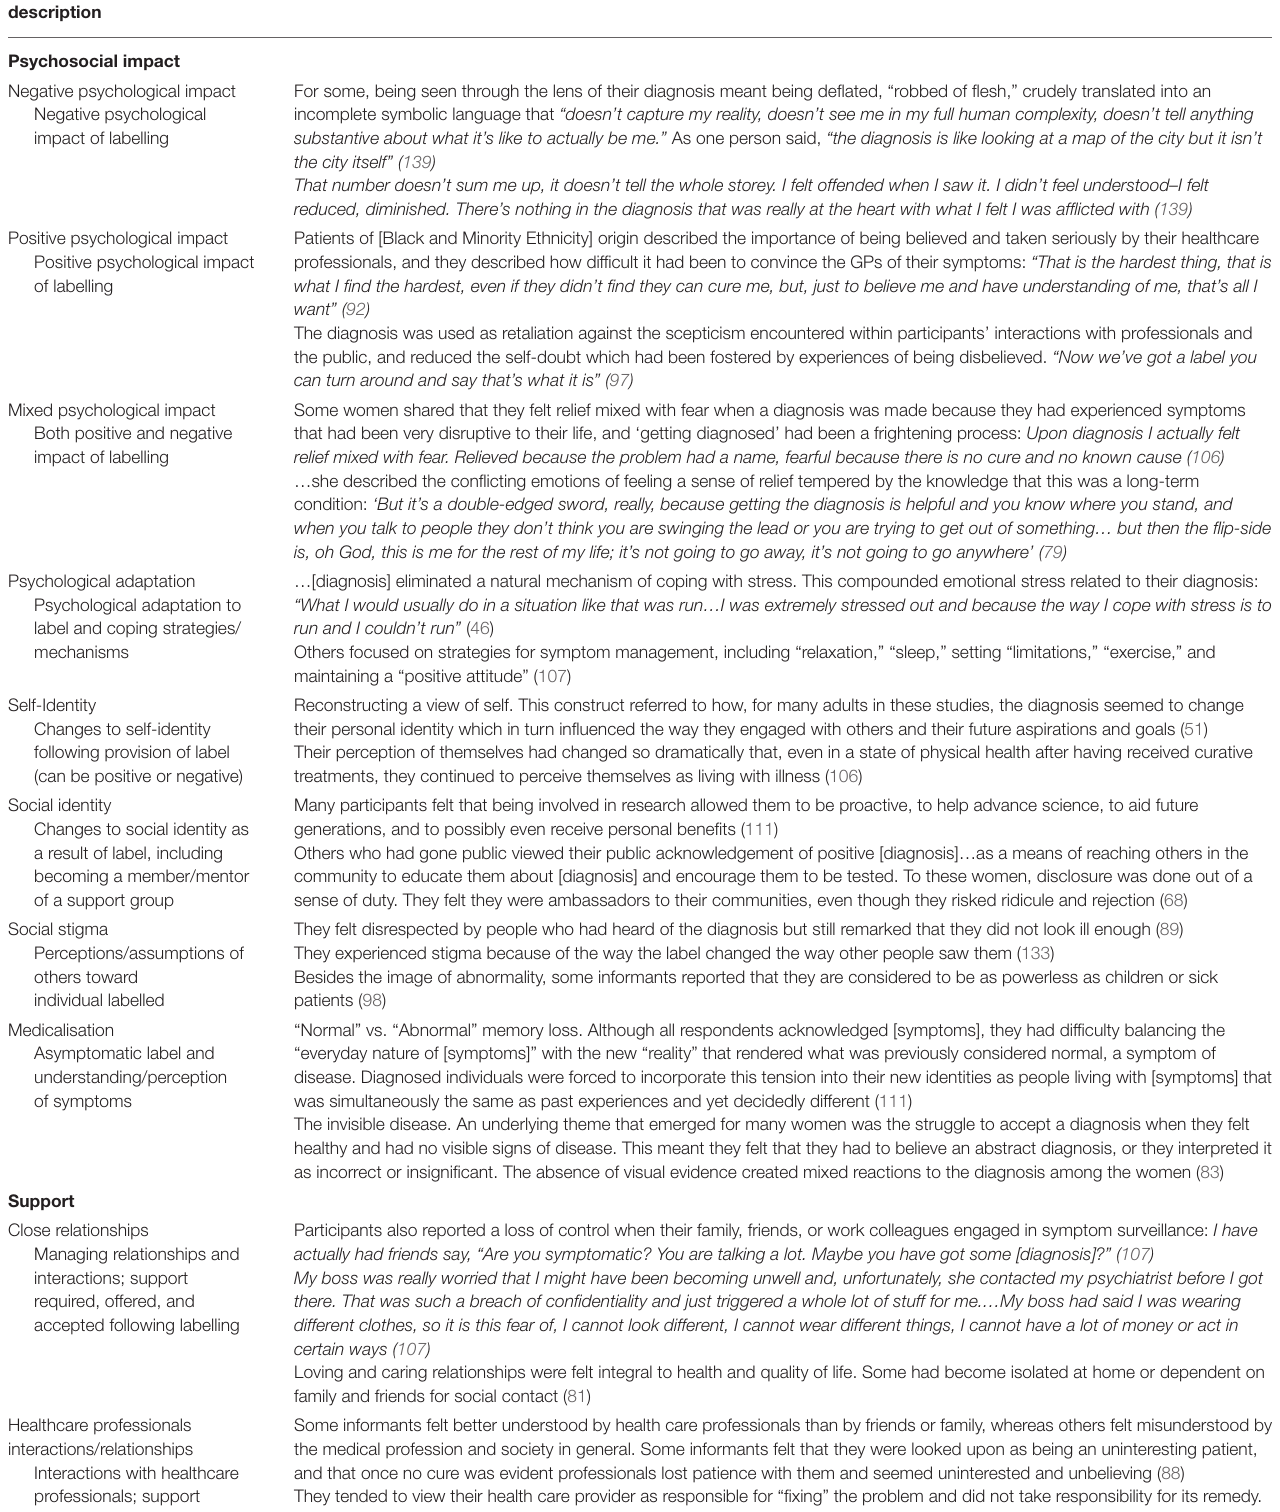
TABLE 4 | Major and subthemes arising as consequences for the individual. Theme, subtheme,